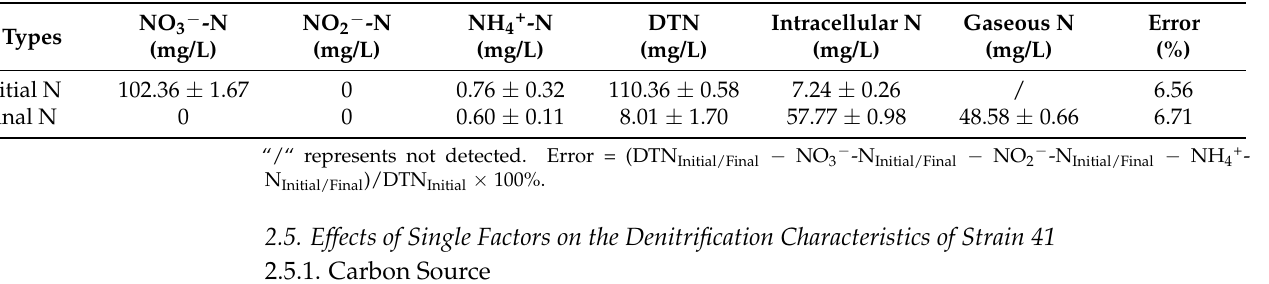
Table 2. Nitrogenbalanceof Pseudomonas sp.